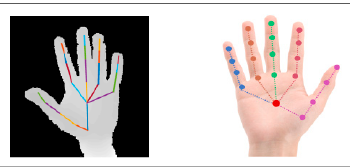
Figure 9. Example of skeleton recognition using depth and skeleton dataset to representation hand skeleton model [62].